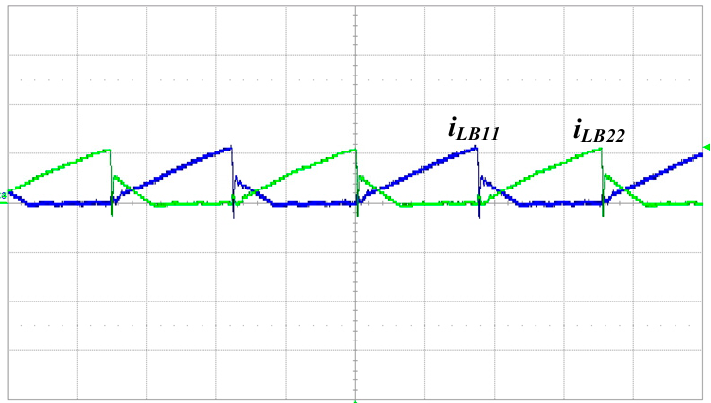
Figure 8. Measured coupled inductor currents i LB 11 (2 A/div) and i LB 22 (2 A/div); time scale: 5 μ s/div.